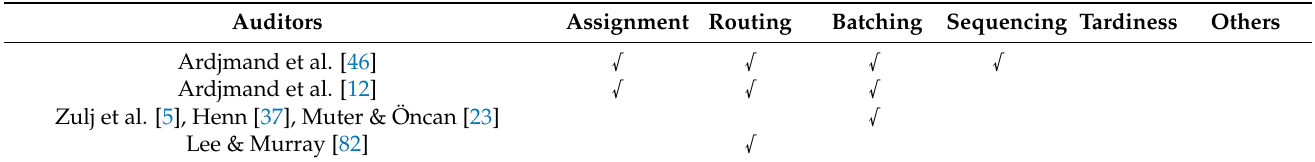
Table 9. Overview of the reviewed articles on Minimization of Makespan.